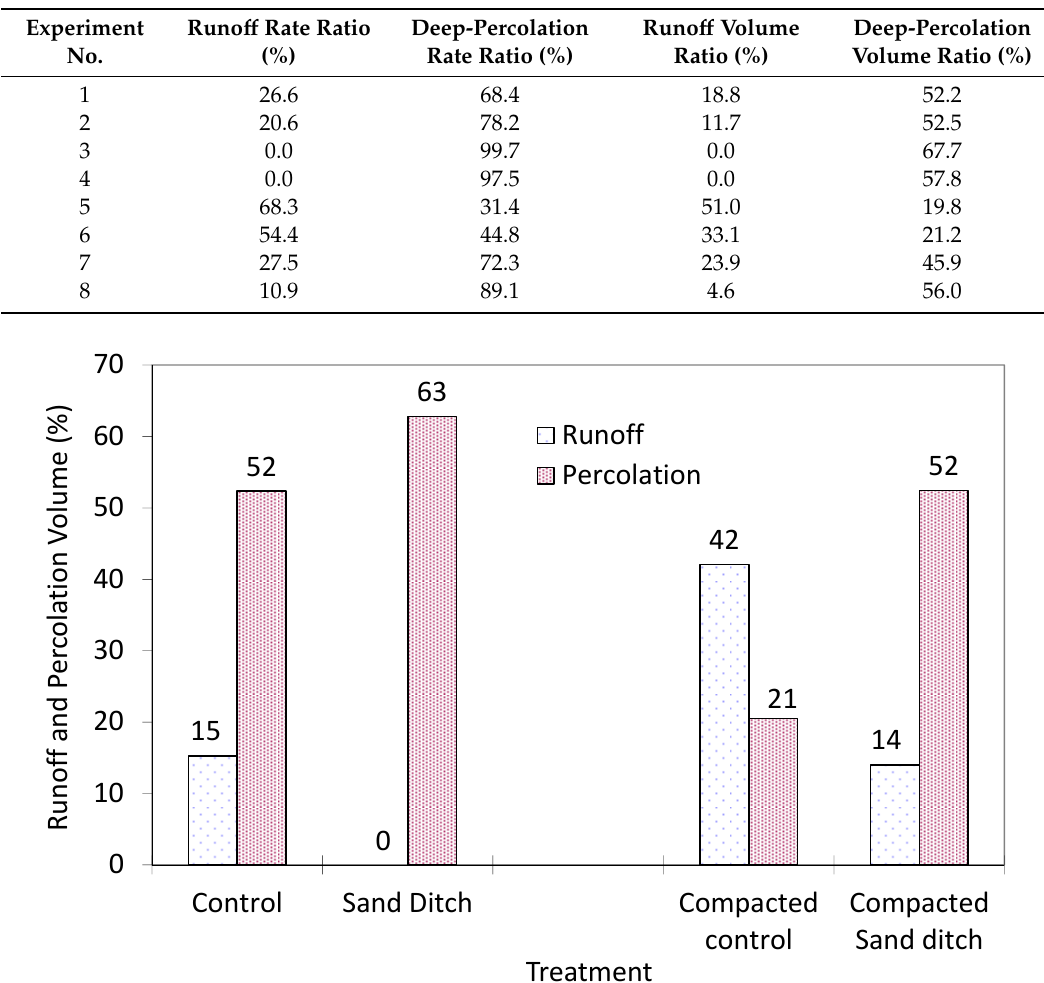
Figure 8. Average of runo ff and deep-percolation volume as percentage of the inflow volumes for the experimental trials.